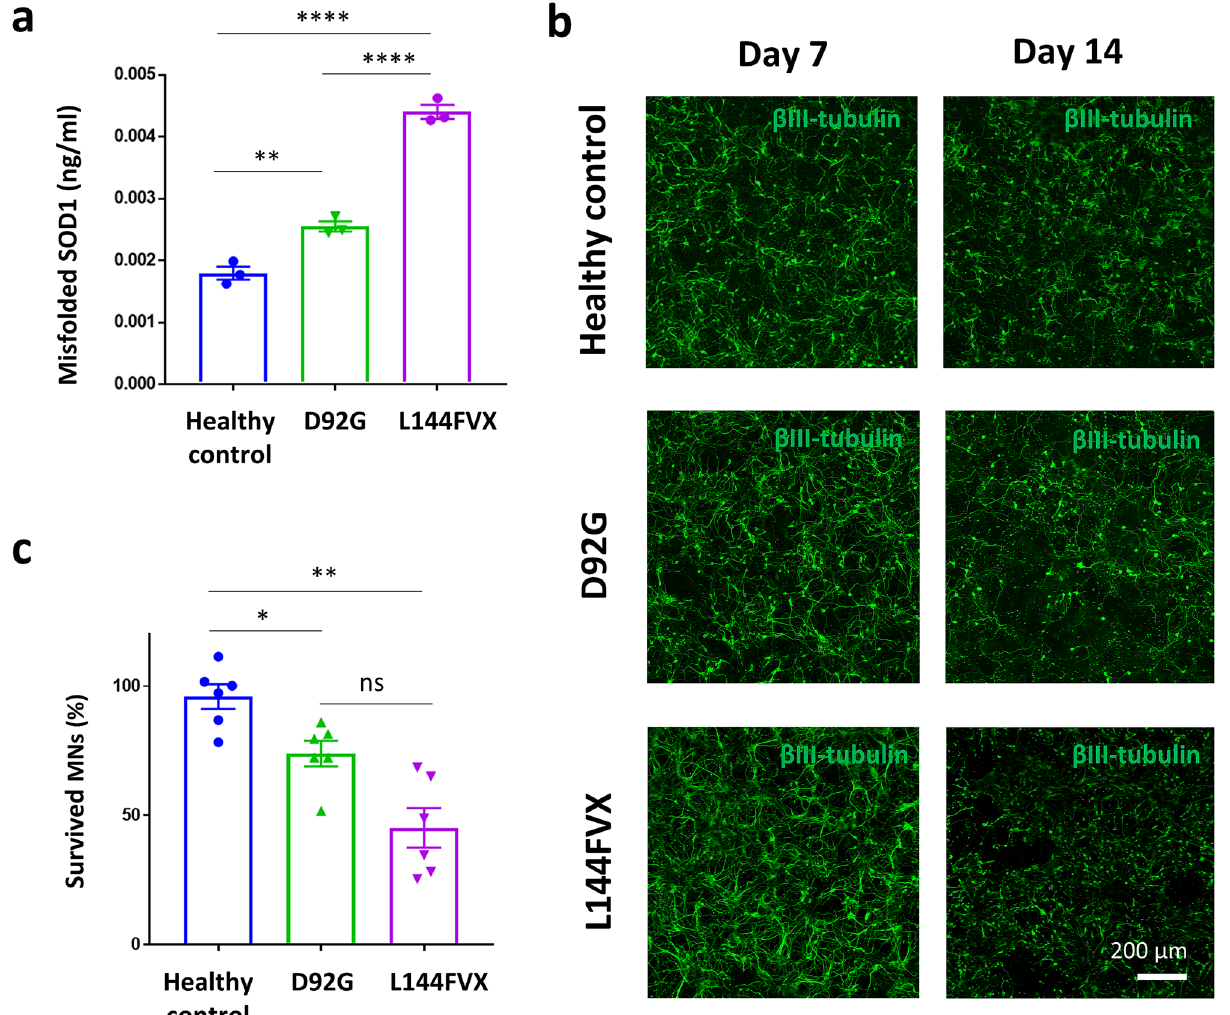
Figure 4. iPSC-derived motor neurons from patients with ALS. ( a ) Misfolded SOD1 in iPSC-derived motor neurons from a healthy control (201B7) and a patient with ALS carrying SOD1-L144FVX (A3316), and a patient with ALS carrying SOD1-D92G (A161EL1). ( b ) Representative images of iPSC-derived motor neurons derived from each patient on days 7 and 14. Scale bar 200 µm. ( c ) Evaluation of vulnerability of